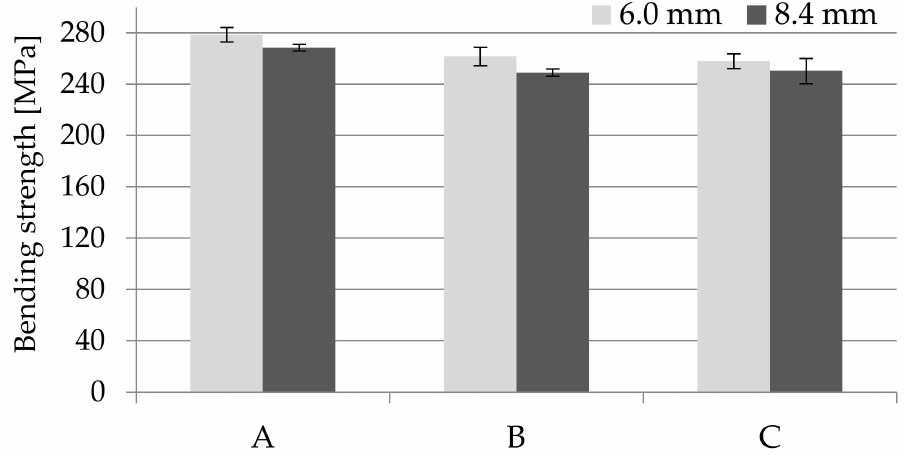
Figure 14. Influence of nitrogen pressure on the bending strength for unfoamed and foamed thick- walled PA66 GF30 molded parts, where A is a solid sample, while B and C are foamed at 16 and 20 MPa nitrogen pressure